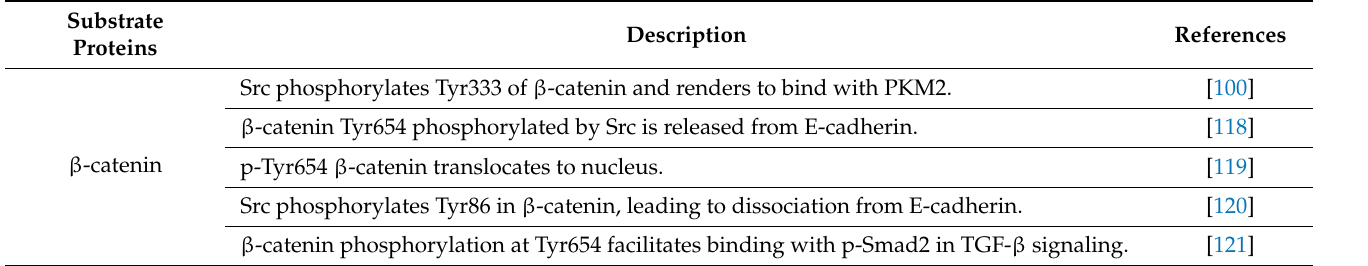
Figure 6. Interaction between Src and Wnt signaling pathway. With Wnt stimulation, Src associates with LRP5/6 and ROR1/2 receptors and is activated. In addition, Src binding to Disheveled ensures Src activation and Src in turn phosphorylates Tyr18, 27, and 275 of Dishevelled, contributing to Wnt signaling. Furthermore, Src phosphorylates Fzd at Tyr552 to stimulate Wnt signaling. However, LRP5/6 Tyr1460 phosphorylation by Src leads to a negative regulation of Wnt signaling. In particular, Src phosphorylates β -catenin Tyr333, facilitating a nuclear translocation along with association with PKM2. Remarkably, p-Ser9 GSK-3 β , which is induced by ROCK1, is able to phosphorylate Src at Ser493 and Ser51, leading to Src inactivation while phosphorylating in certain circumstances at Ser43, leading to its activation. Table 3. Substrate proteins of Src in Wnt